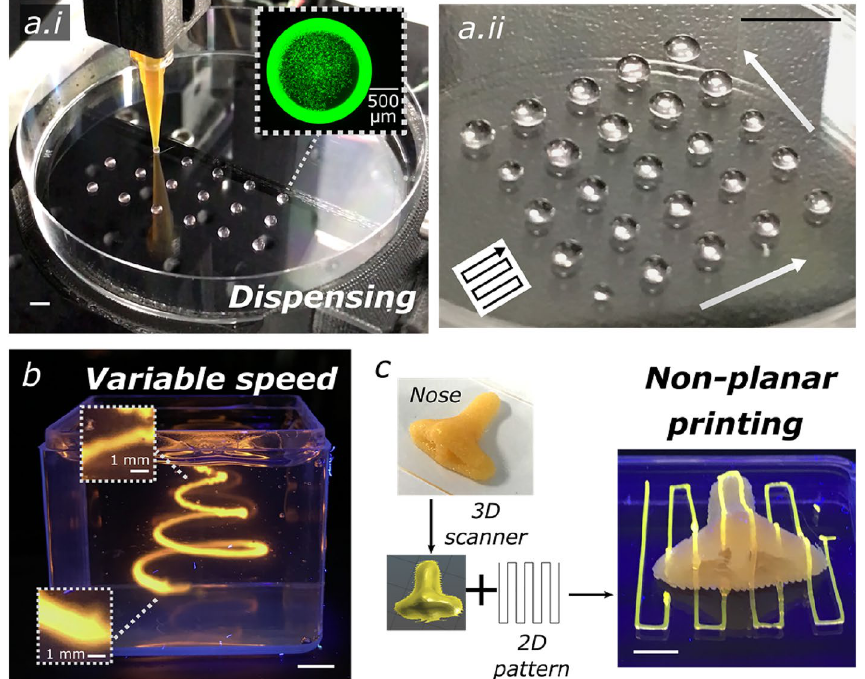
Figure 4. Versatile functionalities of Printer.HM. ( a ) Automated dispensing of cell suspension on a petri dish at ( a.i ) constant droplet volumes and ( a.ii ) variable droplet volumes. The black arrow in ( a.ii ) indicates the direction of the dispensing path, and the white arrows depict the controllable droplet size variation from small to large volume. ( b ) A spiral curve made of Pluronic F127 printed with variable speed. ( c ) Non-planar printing of a Pluronic F127 line pattern on a 3D nose model. Scale bars = 5 mm.